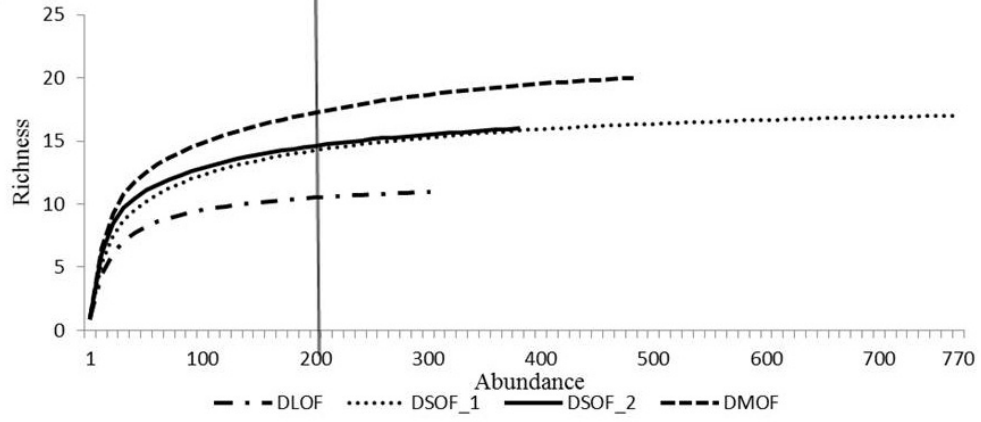
Fig 1. Rarefaction curves for four areas in the Brazilian Atlantic forest. DLOF: dense lowland ombrophilous forest, DSOF_1: dense submontane ombrophilous forest, area 1, DSOF_2: dense submontane ombrophilous forest, area 2, DMOF: dense montane ombrophilous forest.